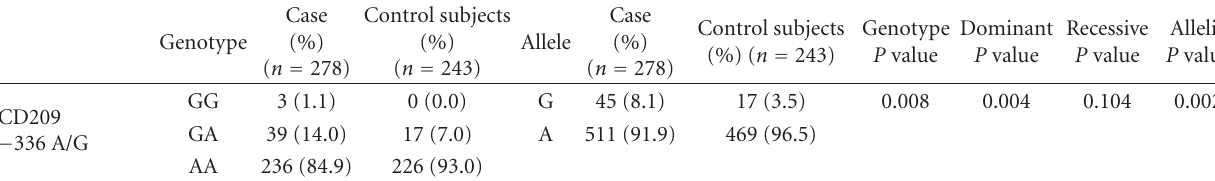
Table 1: Genotype frequencies for CD209 − 336 A/G and Kawasaki disease susceptibility.